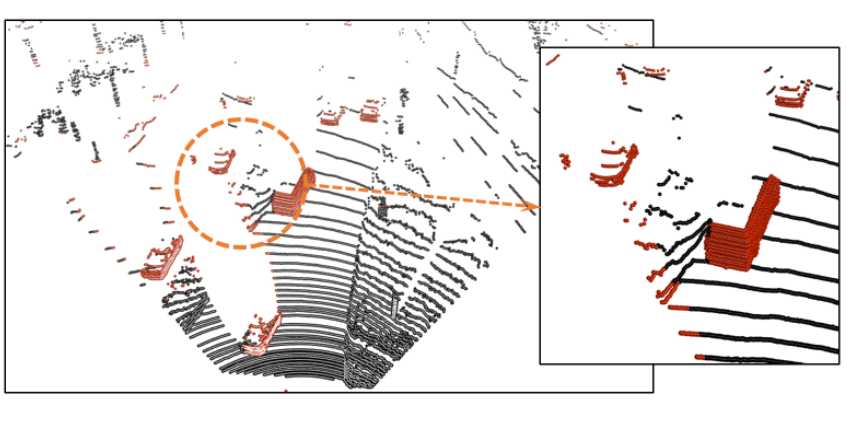
Figure 1. ( a ) Semantic segmentation results by DeeplabV3+ [18]; ( b ) the point cloud is painted with the 2D segmentation results. Cars are denoted in red. The zoomed figure depicts the misclassified ground